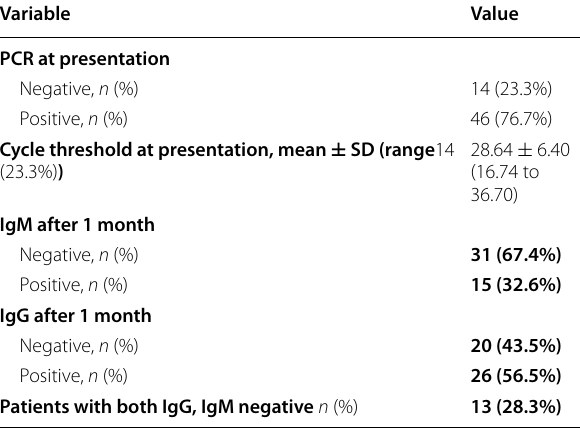
Table 3 Results of laboratory workup